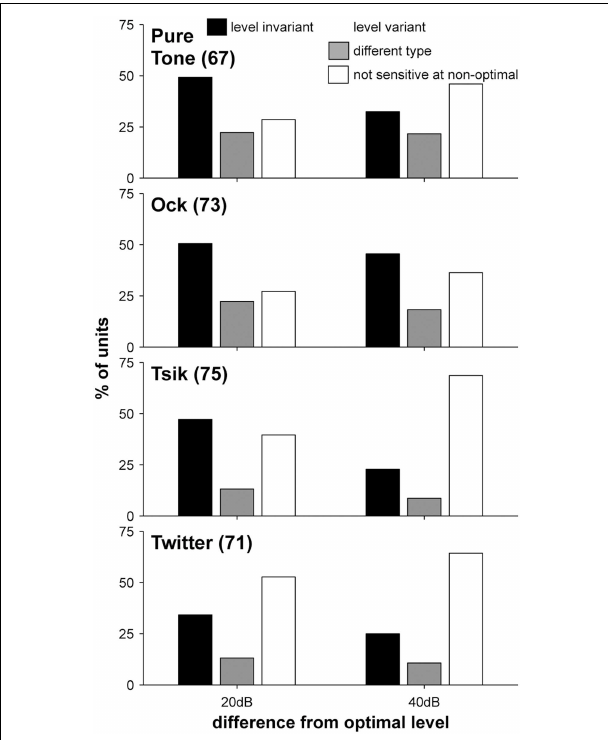
FIGURE 8 | Distribution of level invariance in ILD sensitivity with respect to stimulus type and ABL. Sub-plots in each row illustrate data from different stimuli; left and right bar groups indicate the ABL difference from ABL opt . Shading indicates the percentage of each cell type as indicated by the legend. Numbers in brackets the number of cells included for each